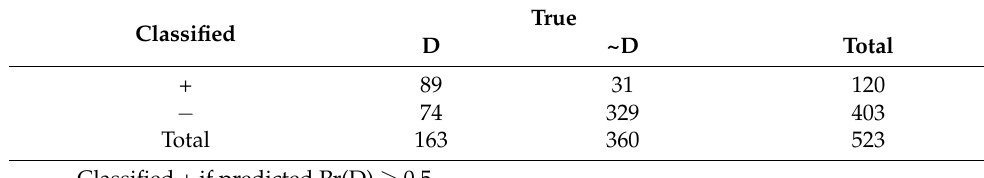
Table 6. Classification